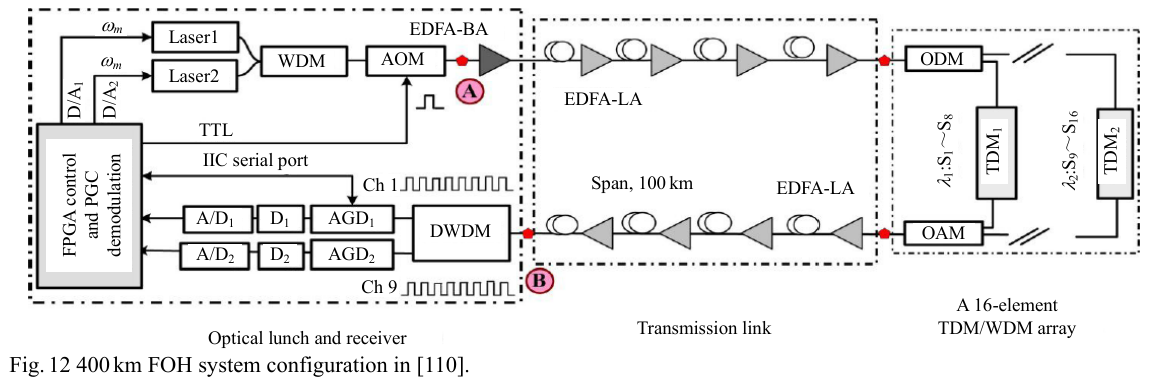
Fig. 12 400 km FOH system configuration in [110].